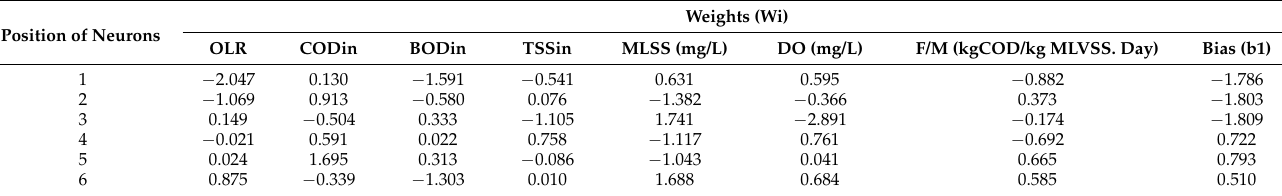
Table A4. Input weights and biases of the ANN model for aerobic process.